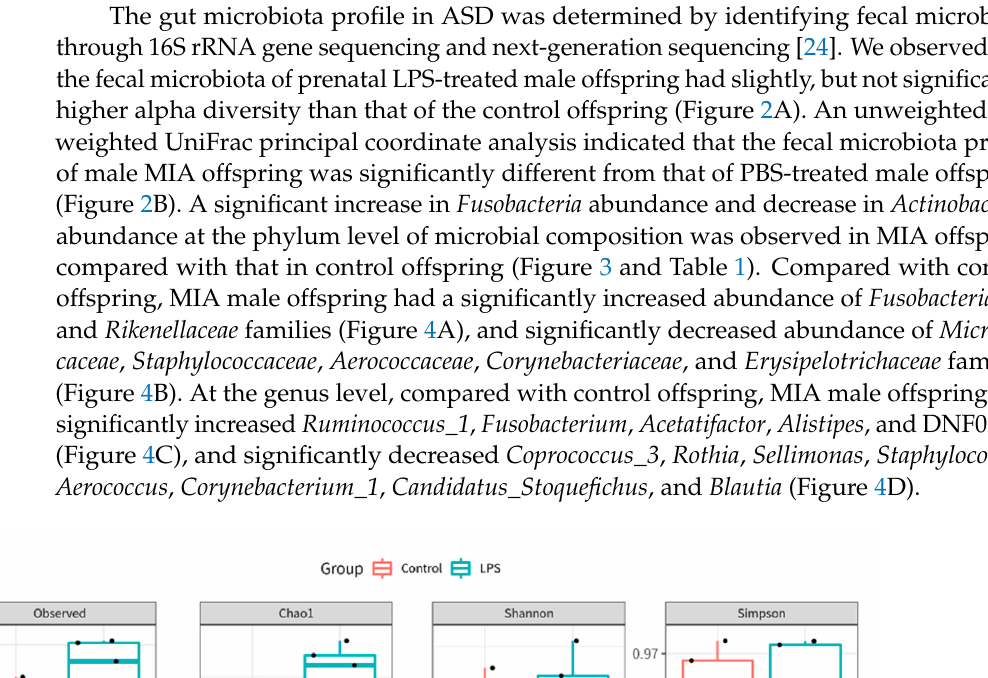
Figure 2. Fecal microbiome distribution in male maternal immune activation (MIA) offspring. The feces of prenatal lipo- polysaccharide (LPS)-stimulated male offspring (LPS group) and control rats were prepared for fecal microbiome profiling through high-throughput sequencing of the 16s rRNA gene on the Illumina MiSeq system. ( A ) Alpha diversity of MIA offspring (LPS) and controls. ( B ) Principal coordinate analysis plot based on unweighted or weighted UniFrac distance of omeprazole MIA offspring and control samples. A significant difference in beta diversity was evaluated using permuta- tional multivariate analysis of variance (vegan:adonis, 1000 permutations), and beta dispersion was quantified using a betadisper (vegan:betadisper, 1000 permutations). Both indices achieved adonis p < 0.05 and betadisper p > 0.05.